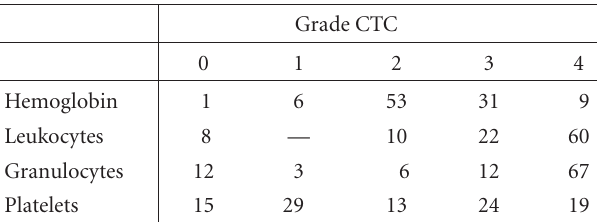
Table 4: Maximum hematologic toxicity (% of patients). Table 5: Grades 3 and 4 hematologic toxicity by ifosfamide dose during the first 6 cycles (% of